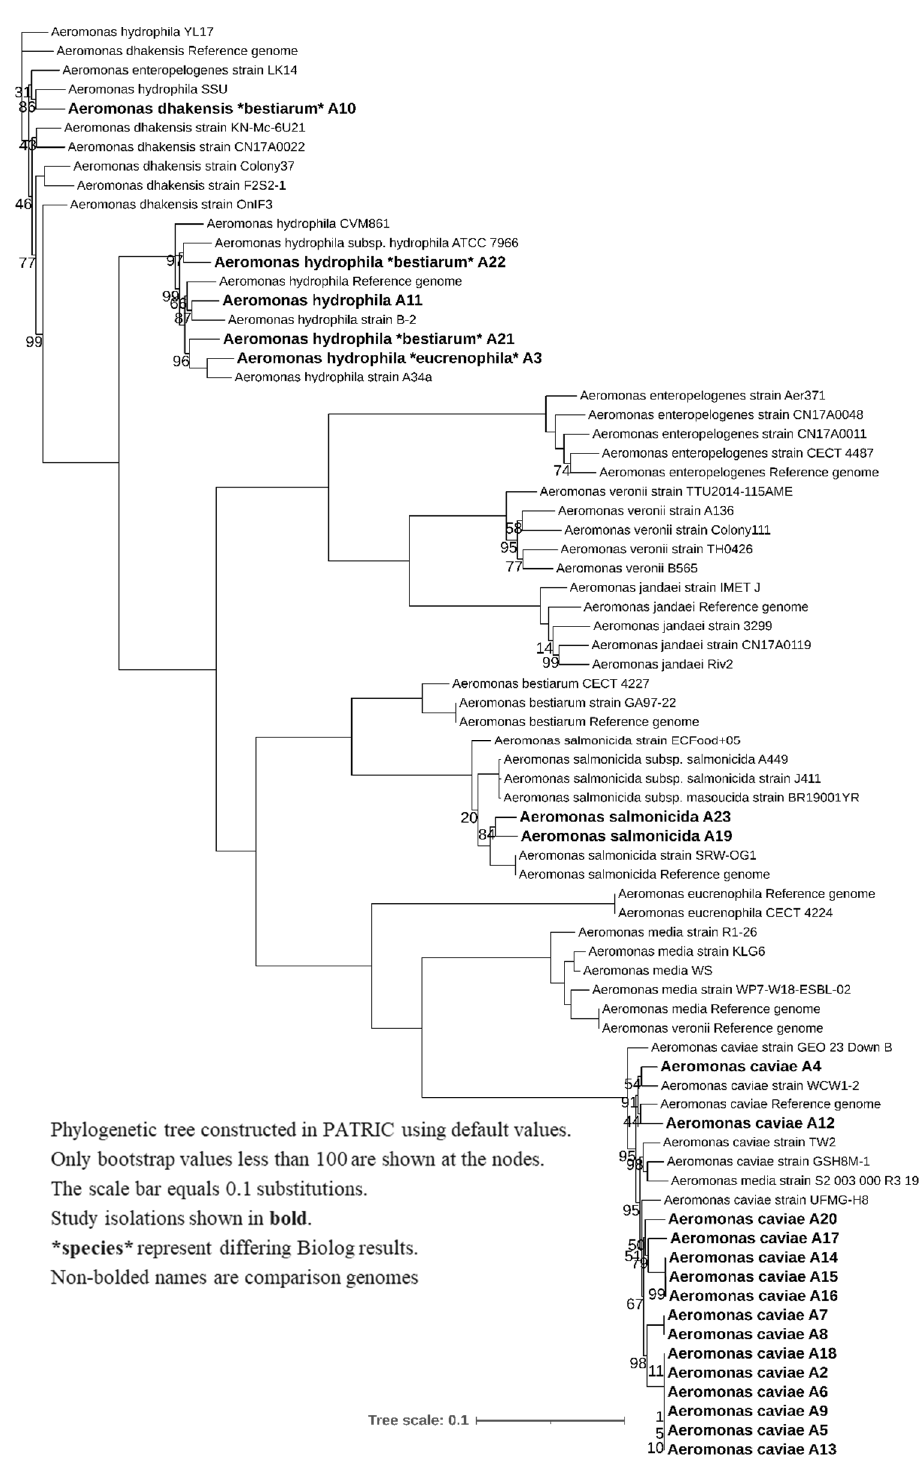
Figure 3. Phylogenetic tree.